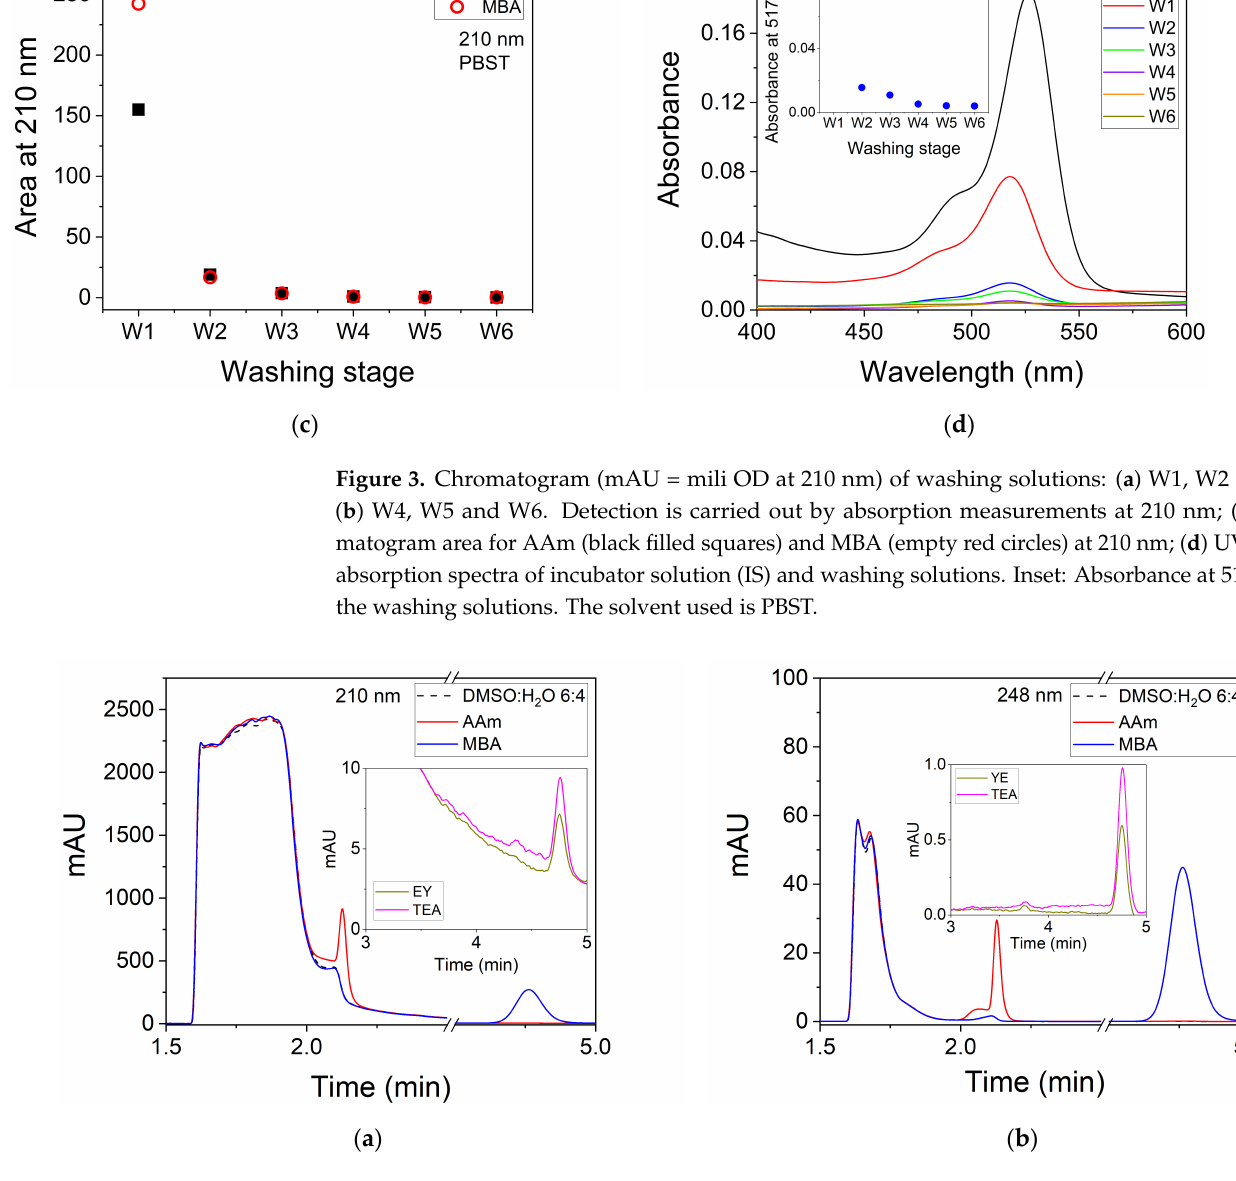
Figure 4. Chromatograms (mAU = mili OD at 210 and 248 nm) of standard solutions of AAm, MBA, EY and TEA. The concentration of each compound is 50 ppm. The solvent used is DMSO:H 2 O 6:4. Detection is carried out with a diode array detector at: ( a ) 210 nm and; ( b ) 248 nm. Chromatograms of the six washing samples with DMSO:H 2 O 6:4 are shown in Figure